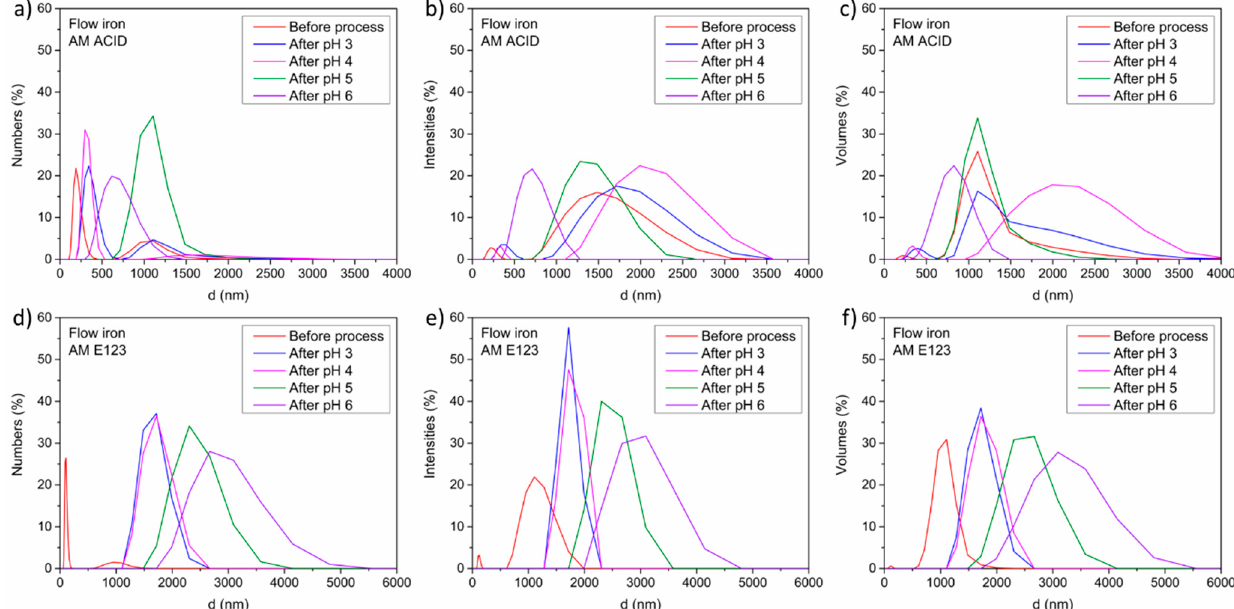
Figure 7. Size characterization results for the catalysts after the process with numbers of the particles ( a ), intensities ( b ), and volumes ( c ) of AM ACID and numbers of the particles ( d ), intensities ( e ), and volumes ( f ) of AM E123.